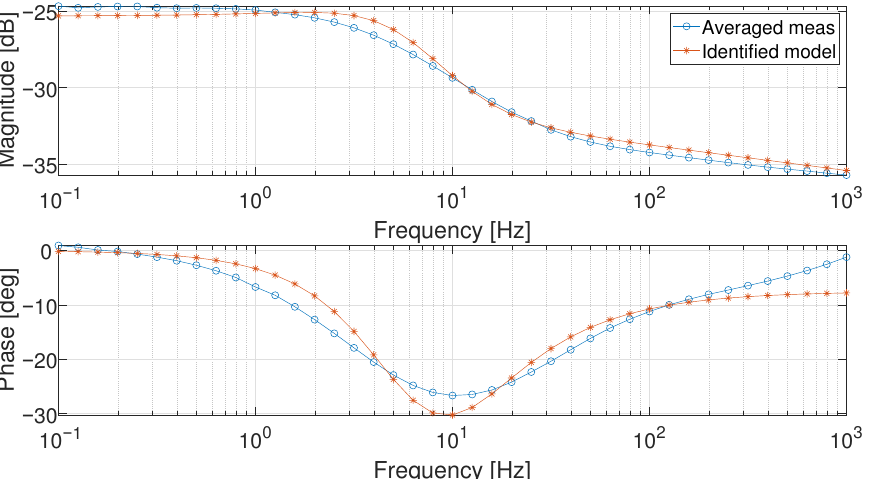
Figure 20. Bode diagram of the averaged measurement (circle marked) and identified model (asterisk marked) at 1A.